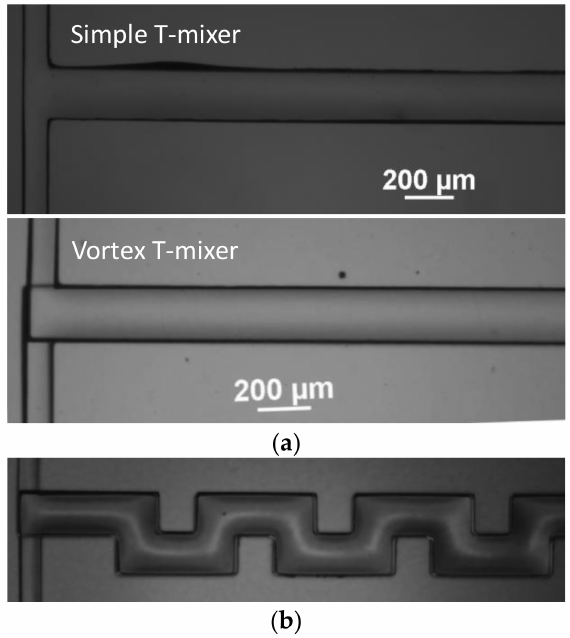
Figure 3. Micrographs of the experimental devices: ( a ) simple and vortex micro T-mixers and ( b ) planar serpentine channel integrated with vortex